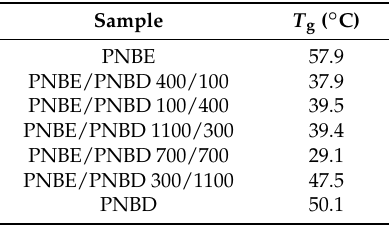
Table 3. Experimental T g values.